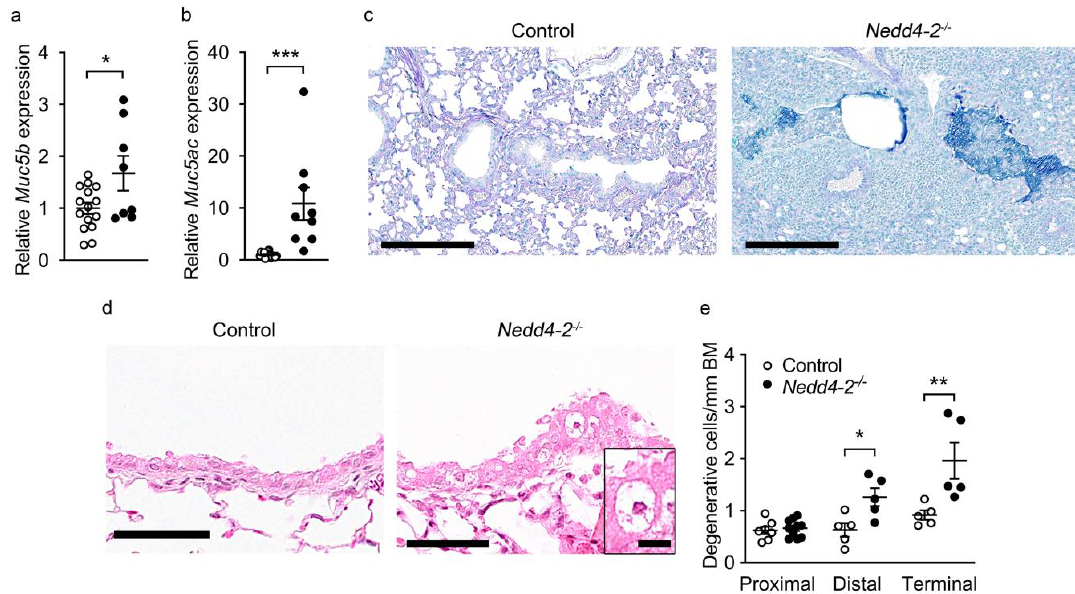
Figure 5. Congenital deletion of Nedd4-2 in lung epithelial cells causes mucus plugging and epithelial necrosis in distal and terminal airways of neonatal mice: ( a , b ) mRNA expression levels of Muc5b ( a ) and Muc5ac ( b ) in whole lungs from congenital Nedd4-2 −/− and control mice. ( c ) Representative airway sections from 3-week-old congenital Nedd4-2 −/− and control mice stained with AB-PAS to illustrate the presence of mucus. Scale bars, 200 µm. ( d ) Representative H&E stained lung sections of distal airways showing degenerative airway epithelial cells in 3-week-old congential Nedd4-2 −/− mice. Scale bars, 50 µm and 10 µm (inset). ( e ) Summary of numeric densities of degenerative airway epithelial cells in congenital Nedd4-2 −/− and control mice. n = 5–10 mice per group. * p < 0.05, ** p < 0.01, *** p < 0.001. Data are shown as mean ± S.E.M.